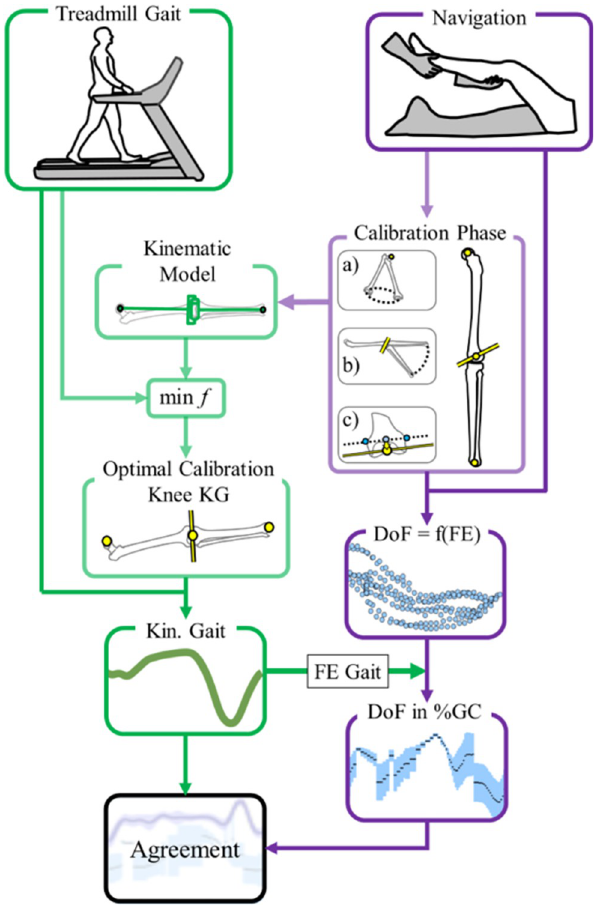
Fig 2. Workflow of kinematic measurements and data analysis. min f represents the two-level optimisation methods used to fit the calibration of the CAS system on the gait measurement, DoF = f(FE) represents the degrees of freedom measured with the CAS system expressed in function of the flexion-extension of knee, FE Gait represents the matching of CAS knee flexion-extension with knee flexion-extension measured during gait to obtain the DoF in percentage of GC (DoF in